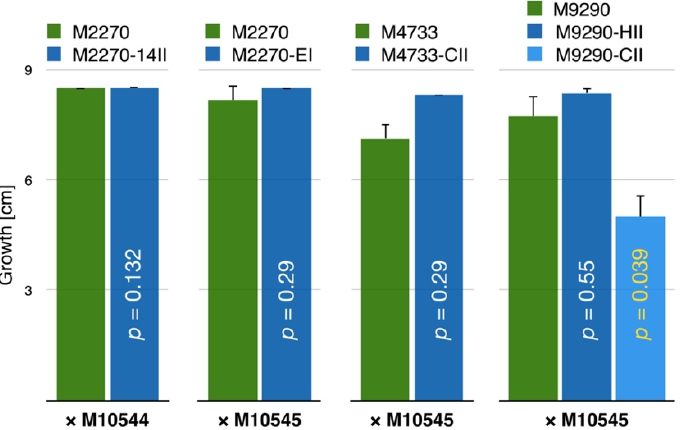
Figure 9. Growth rate of CnFGV1-positive and virus-free isogenic strains of Cryphonectria spp. Column height represents the growth of isogenic virus-free strains (green) or infected recipient strains (dark and light blue) of C. radicalis (M2270, M4733) and C. carpinicola (M9290). Donor strains are C. naterciae M10544 and M10545. Column height represents growth after 7 days incubation. Vertical black lines indicate the standard deviation of three culture replicates, and vertical yellow p -numbers highlight significant growth differences between the virus-free and each infected strain. White p -numbers are nonsignificant considering a critical value of p < 0.05.